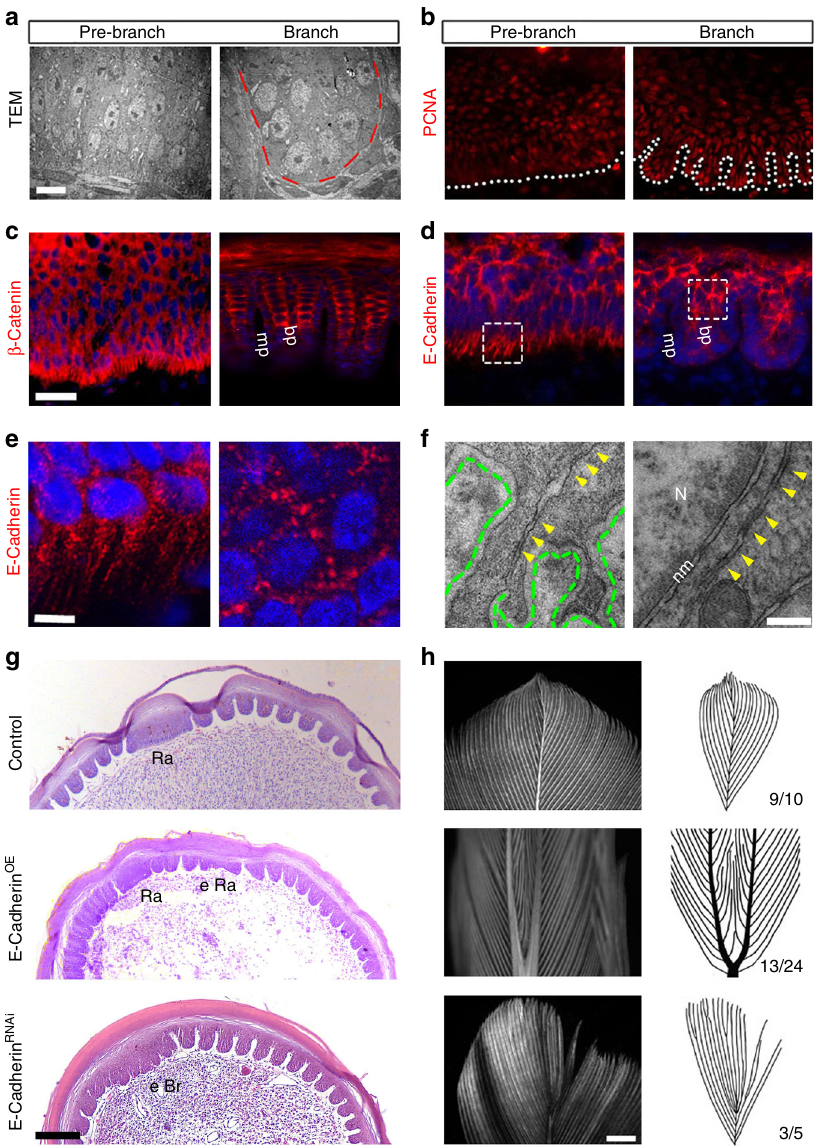
Fig. 4 Topological arrangement of E-Cadherin-mediated cell adhesion is required for feather branching. a , b Neither pre-patterned cell proliferation nor apoptosis play a role in feather branching morphogenesis as shown by TEM analysis and PCNA staining. c , d Differential distribution of β -Catenin and E- Cadherin in feather branching. mp, marginal plate; bp, barb plate. e , f Higher magni fi cation views of regions in d showing E-Cadherin was diffusely distributed in pre-branch feather epithelium, but as puncta in branched barbs ( e ). Arrow heads indicate unstable adherens junctions (AJ) in the fi lopodia, as compare to AJ clusters in branched barbs ( f ). Dashed green lines indicate the basal lamina. Representative images from fi ve repeated experiments are shown. N, nucleus; nm, nuclear membrane. g , h Overexpression or knockdown of E-Cadherin disrupted feather branching. Histology and gross feather morphology are shown. The numbers indicate the occasions of feathers with the phenotype. Ra, rachis; eRa, ectopic rachis; eBr, ectopic branch. Bar = 2 μ m in a , 20 μ m in b-d (shown in c ), 5 μ m in e , 0.3 μ m in f , 100 μ m in g , 2 mm in